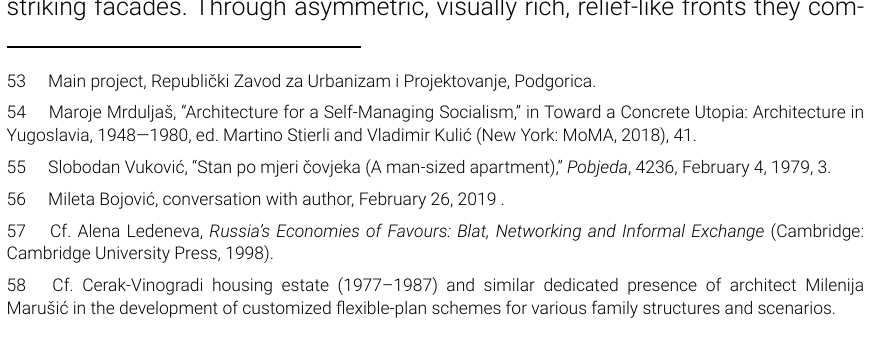
Building D3, 1978. (Source: State Archives of